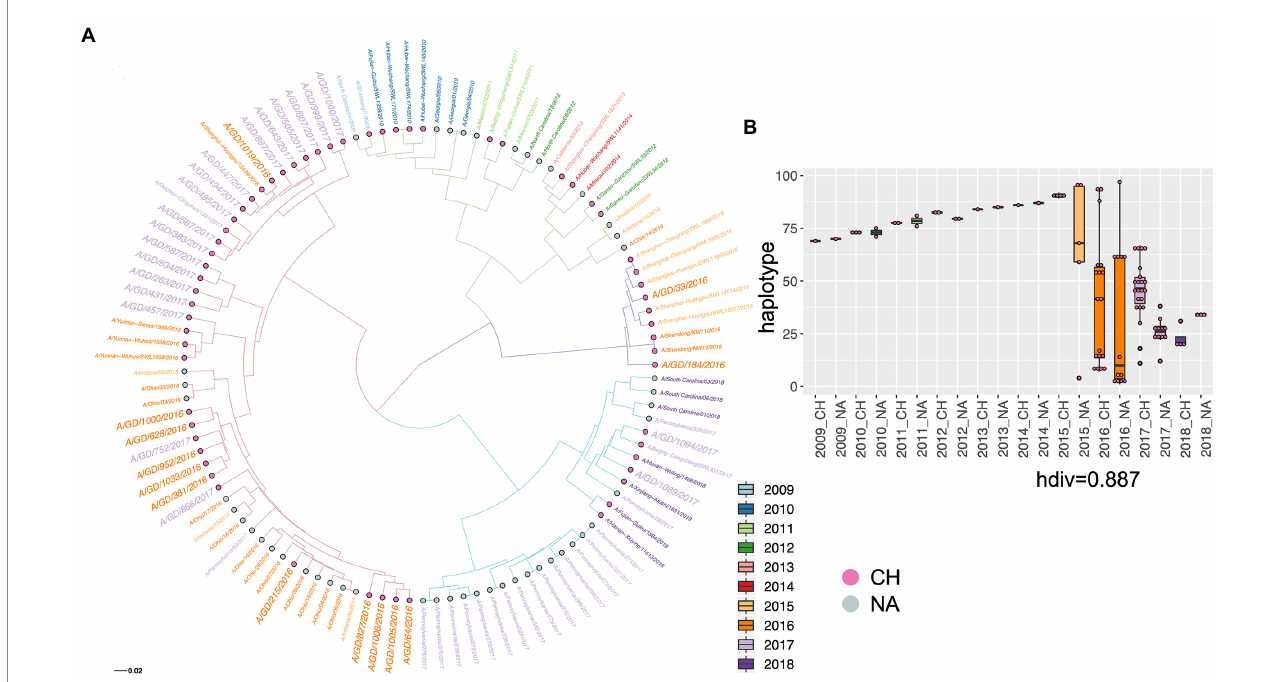
FIGURE 3 The phylogenetic relationship of H1N1 viruses in Guangdong in 2016 and 2017 with H1N1 viruses in China and North American from 2009 to 2018 was displayed by the ML three of HA gene (A) and the haplotype distribution (B) . The viruses from different country and different year are shown by diverse colors, and H1N1 viruses in Guangdong in 2016 and 2017 were highlighted by larger size of text. Haplotype: haploid genotype, is a group of alleles in an organism that are inherited together from a single parent. CH: China, NA: North America. hdiv: haplotype